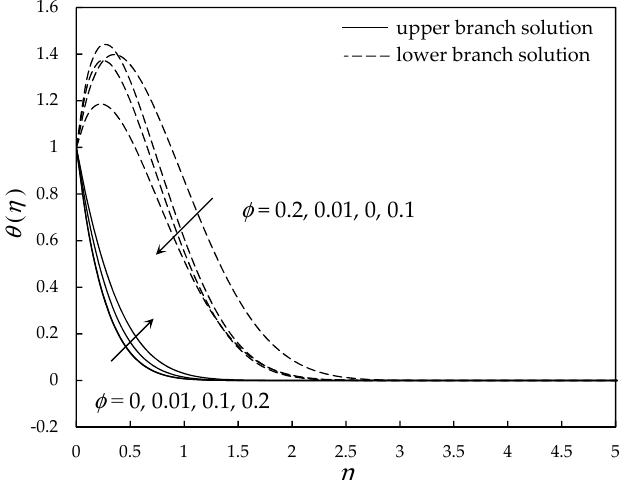
Figure 17. Temperature profiles θ ( η ) for various values of the volume fraction of the nanoparticles φ when Nr = 0.1, K = 0.1, s = 1, c = − 1 and λ = − 2 (opposing flow) for Cu-water nanofluid.